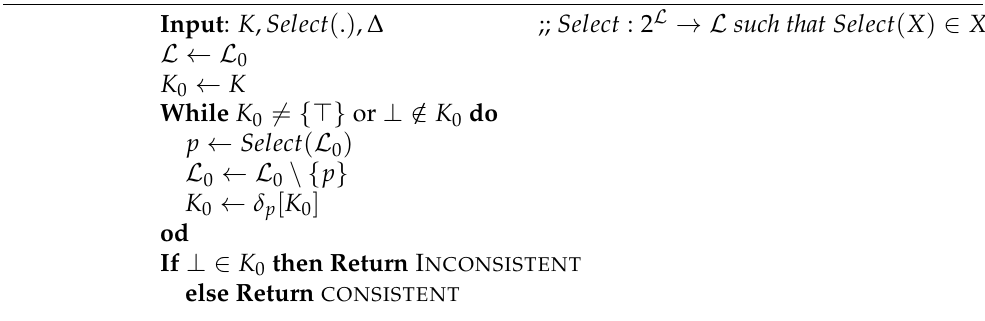
Algorithm 1: Saturation-based algorithm driven by the selection function Select ( . )